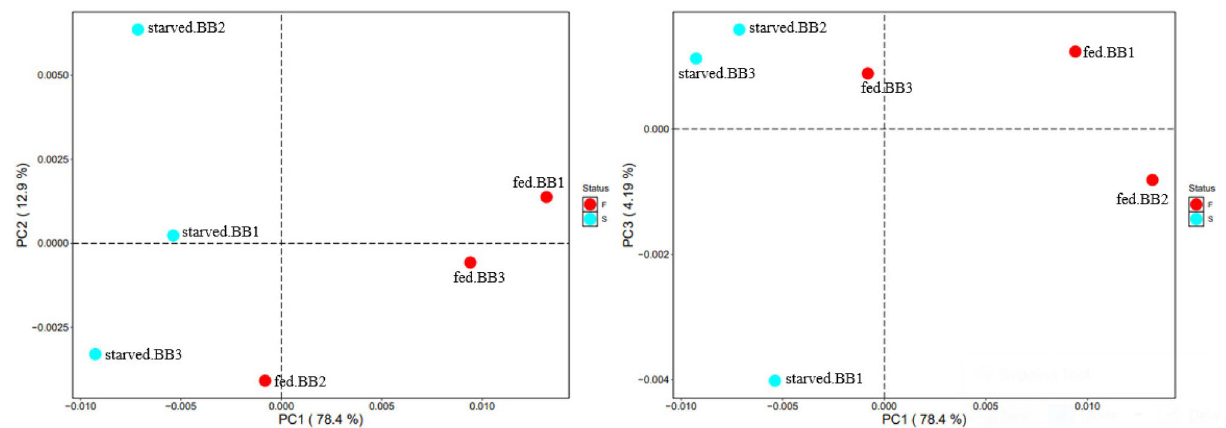
Figure 3. Principal coordinates analysis (PCoA) using Weighted-UniFrac distances of bacterial communities of blood-fed (red points) and starved (turquoise points) bed